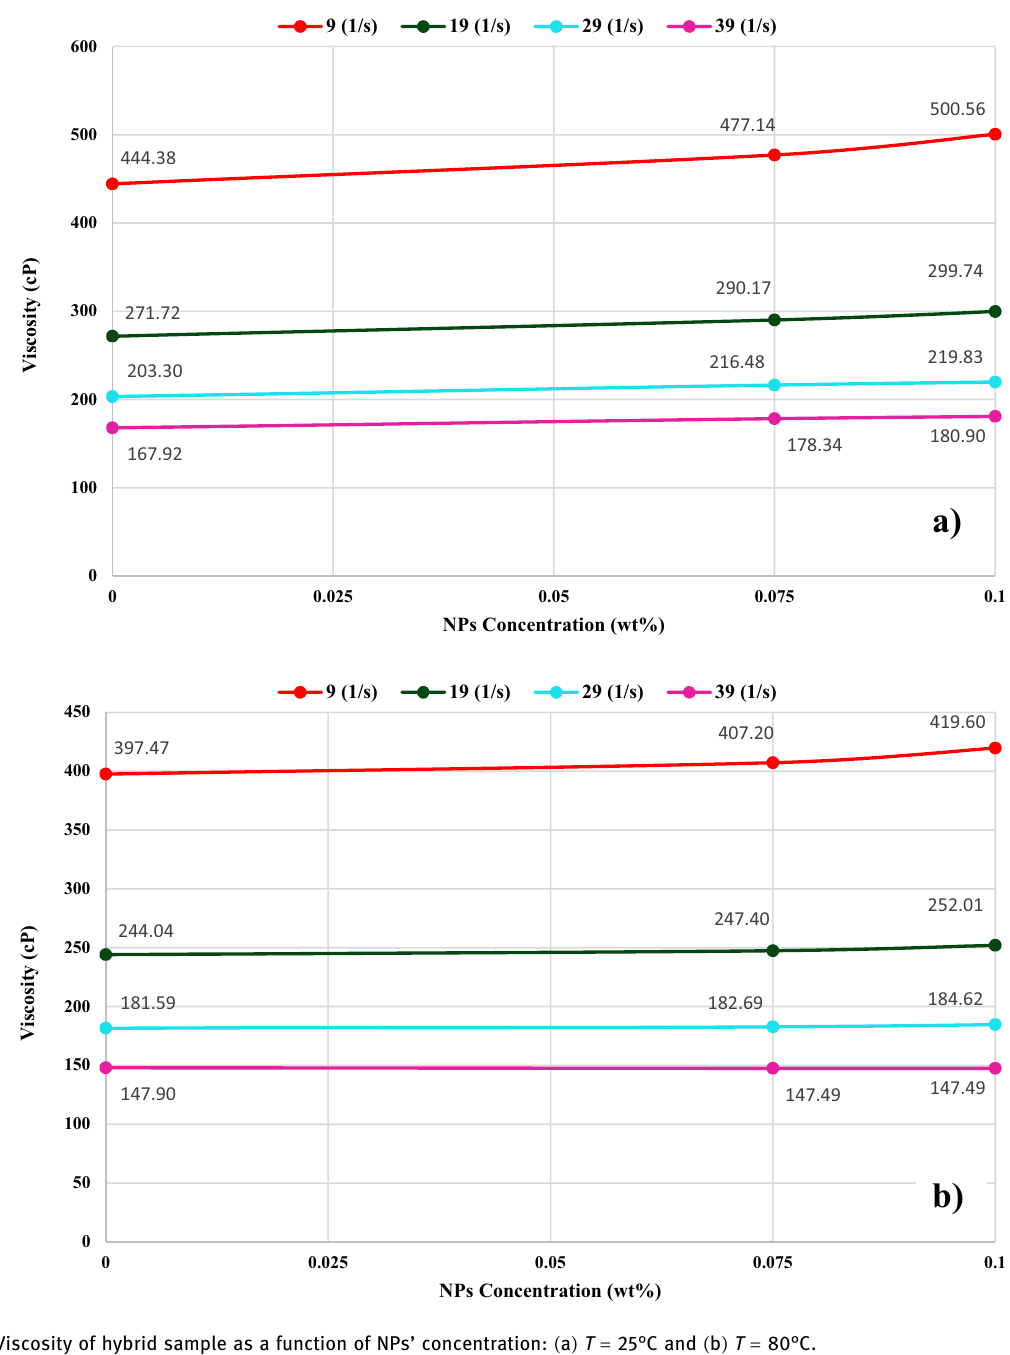
Figure 6: Viscosity of hybrid sample as a function of NPs ’ concentration: ( a ) T = 25°C and ( b ) T =